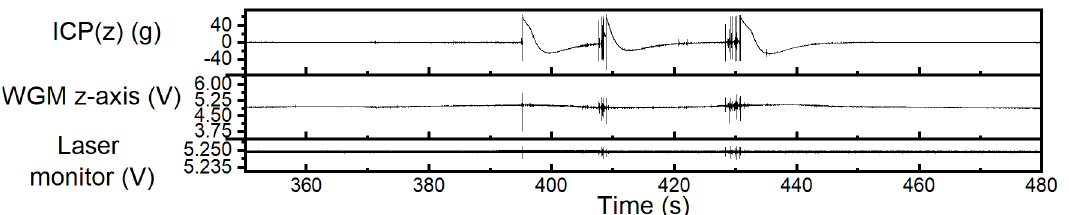
Figure A1. Example trial run with the ICP and WGM accelerometers measuring in the z -axis whilst undergoing large